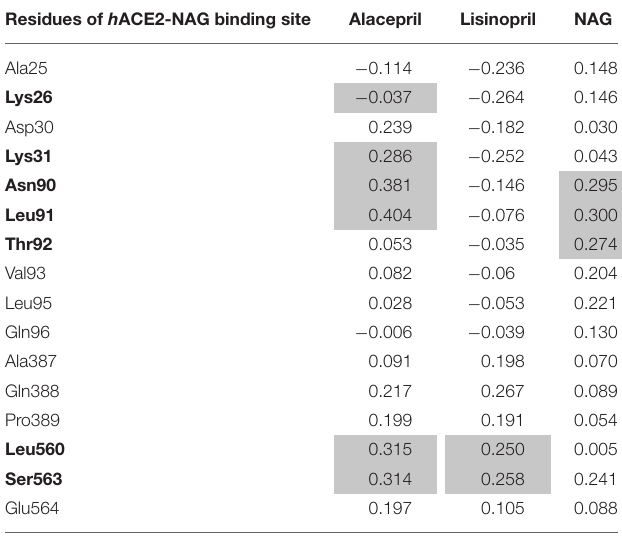
TABLE 3 | Calculated 1 RMSF a trajectories of ligand- h ACE2 proteins along with the MD simulation. Residues of h ACE2-NAG binding